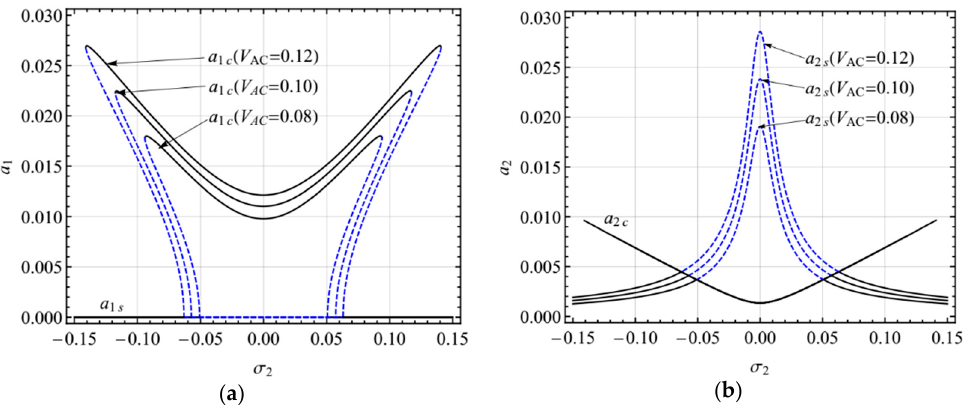
Figure 7. Frequency-response curves of the primary resonance of the second mode for V AC = 0.08, 0.10, 0.12; ( a ) the first mode, ( b ) the second mode.